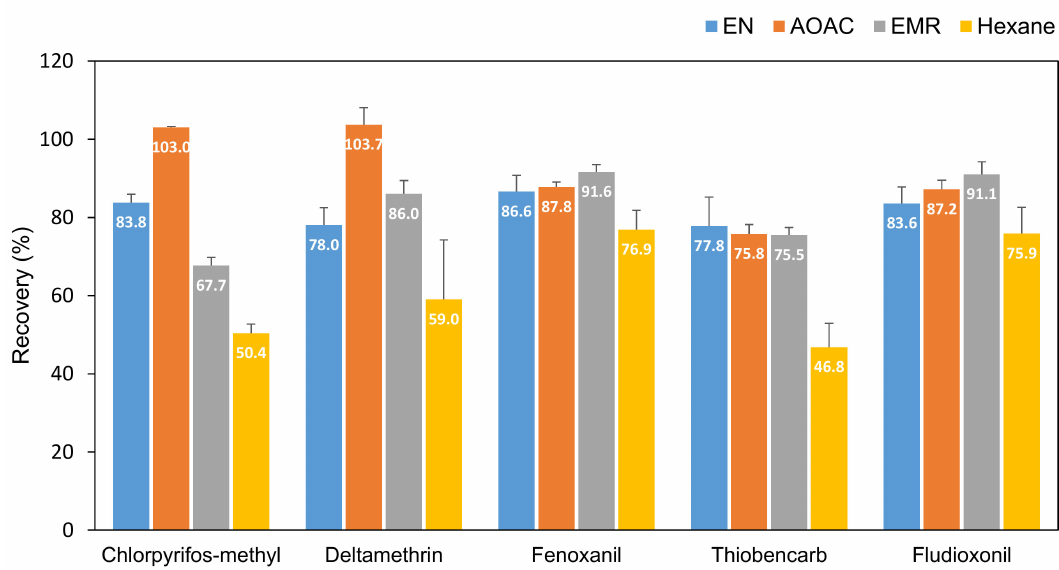
Figure 4. Recoveries of each pesticide obtained from four di ff erent clean-up methods. (1) EN—150 mg MgSO 4 + 25 mg primary secondary amine (PSA) + 25 mg C18; (2) acetate (AOAC)—150 mg MgSO 4 + 50 mg PSA + 50 mg C18; (3) EMR-lipid TM and (4) 10 mL n-